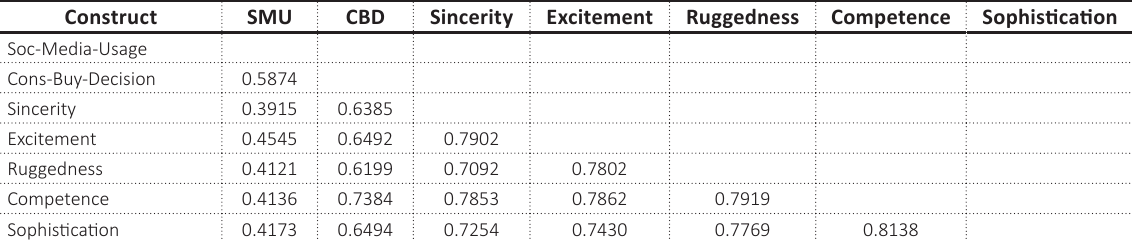
Table 4. Discriminant validity using HTMT